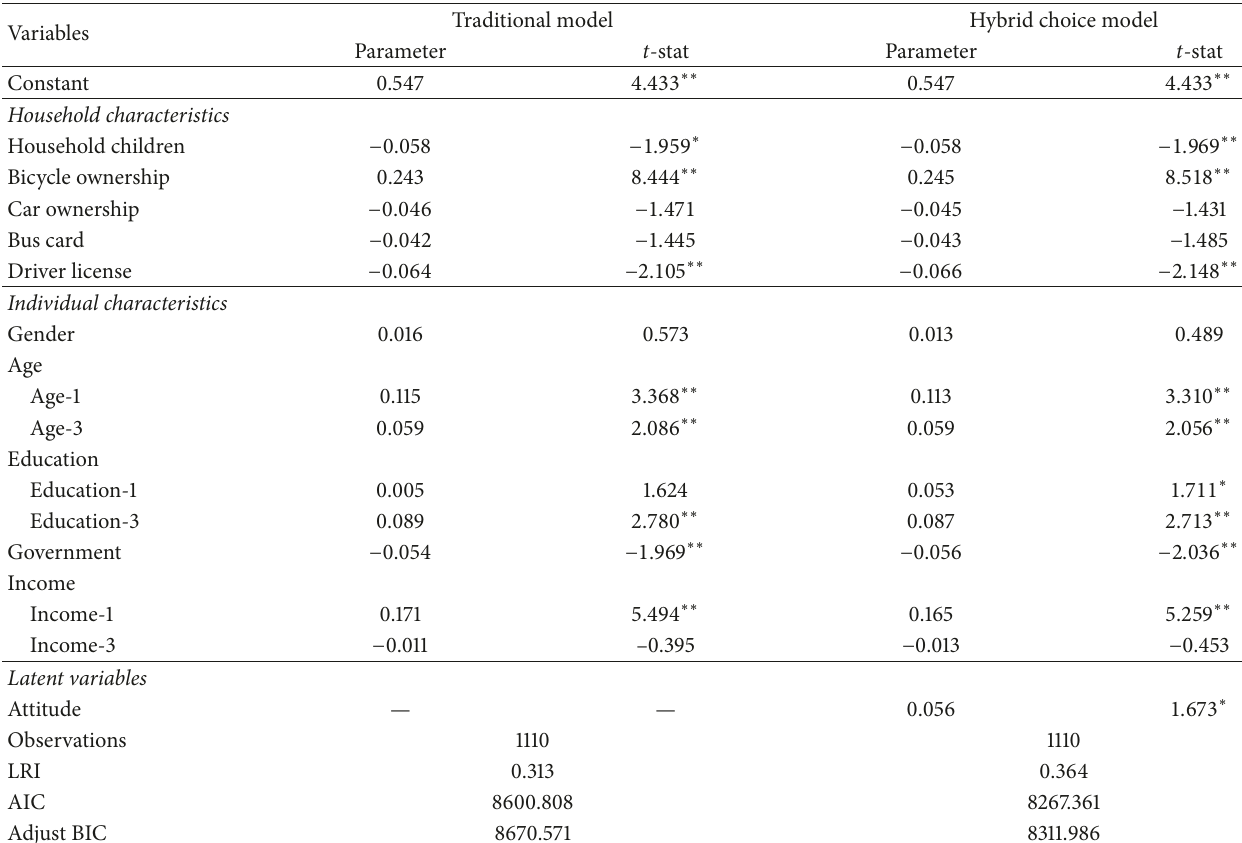
Table 5: Estimation results for the traditional and the hybrid choice